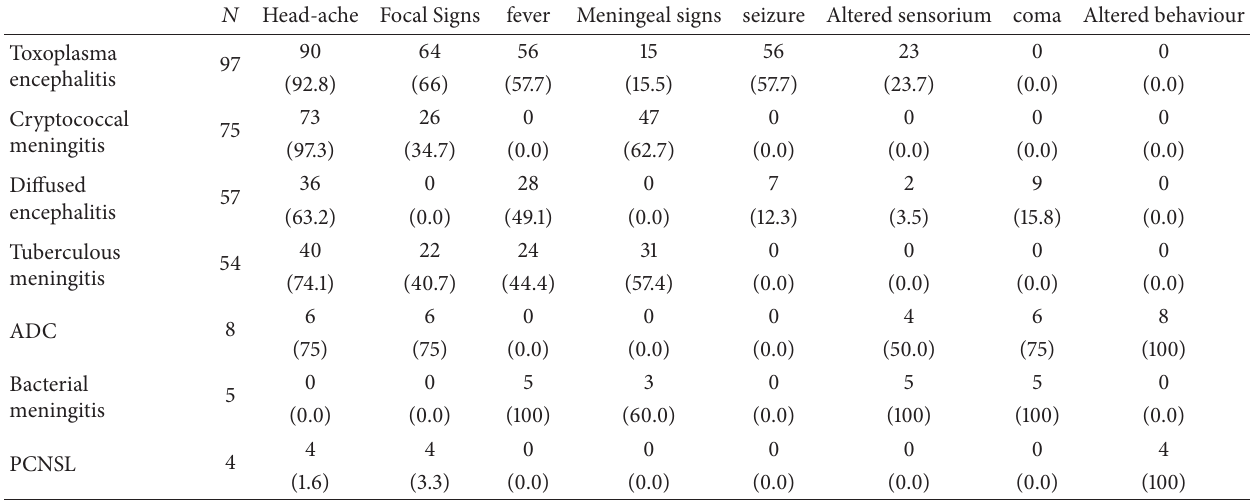
Table 2: Frequency of clinical features of CNS disease in the study population (%).